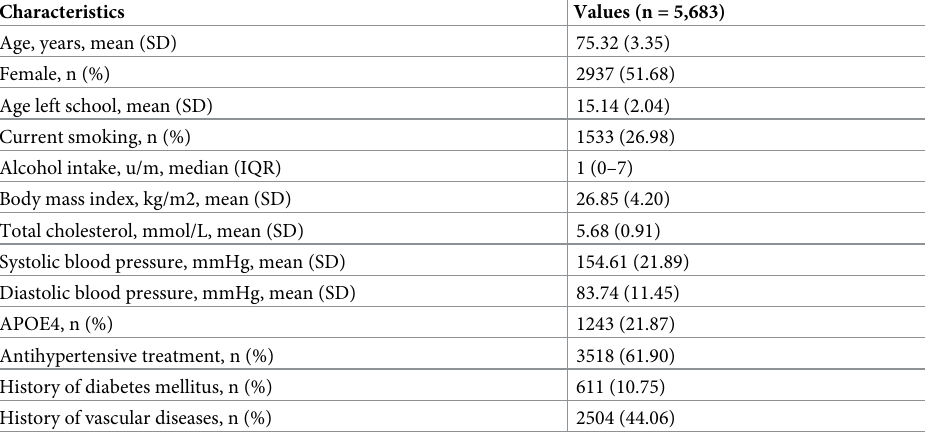
Table 1. Characteristics of PROSPER